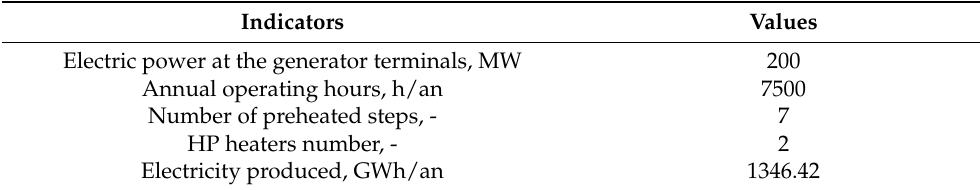
Table 3. Steam power plant characteristics with subcritical